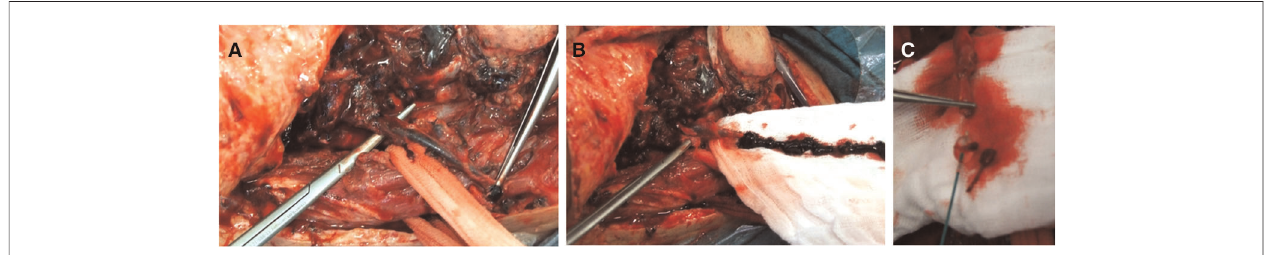
FIGURE 1 | Venous fl ap revision. ( A ) Thrombotic vein detached from the anastomosis. ( B ) Vein squeezing and thrombectomy. ( C ) Subsequent mechanical thrombectomy by using the Fogarty